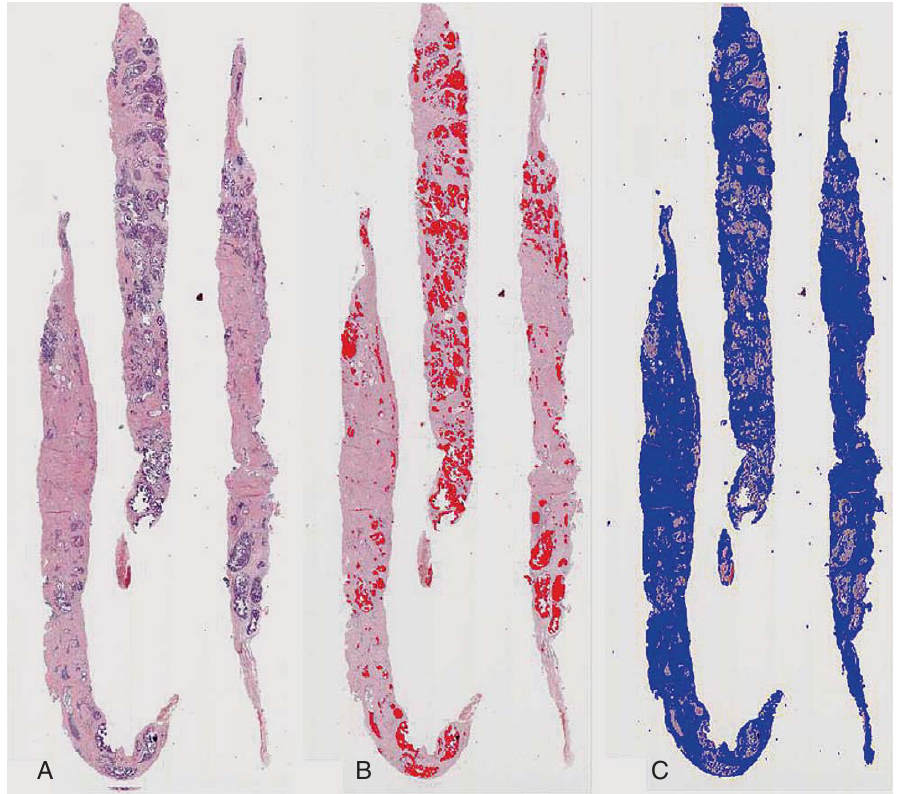
Fig. 6. Breast core biopsy. A low power view (1 × magnification) of a breast core biopsy H&E tissue section, Panel A. A vector was created to recognize and “paint” the breast epithelium. The area of “paint” was calculated to be 5.91mm 2 . A vector was created to recognize and “paint” the breast stroma (Panel C). The area of the “paint” was calculated to be 31.84mm 2 . The percentage of epithelium in the analyzed tissue was 15.65%, and the percentage of stroma was